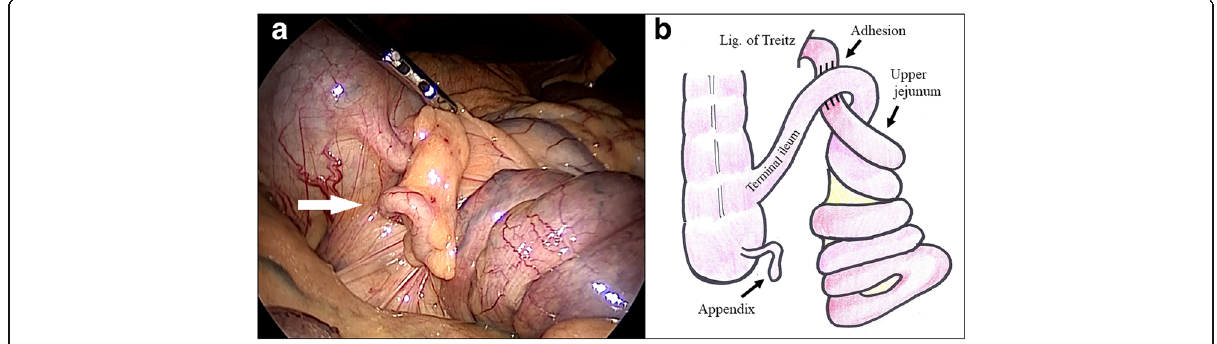
Fig. 2 Intraoperative findings. a Some congestion is observed in the volvulus small bowel. The white arrow indicates the appendix. b Intraoperative schema showing a small bowel volvulus starting from the adhesion of the jejunum and terminal